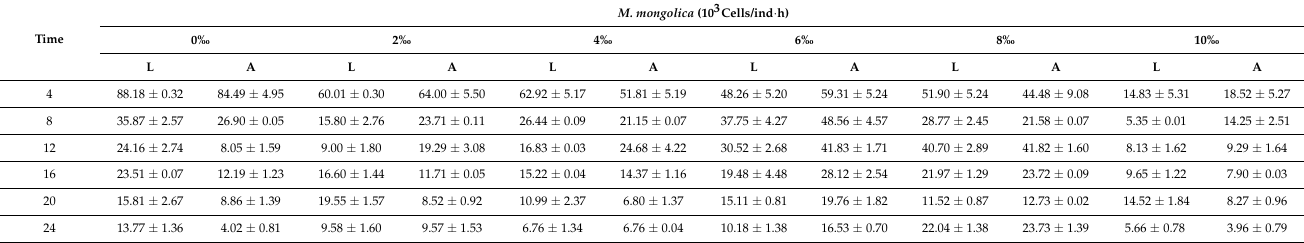
Table 5. Feeding rates of M. mongolica at two age stages with different salinity conditions (data are listed as mean ± standard